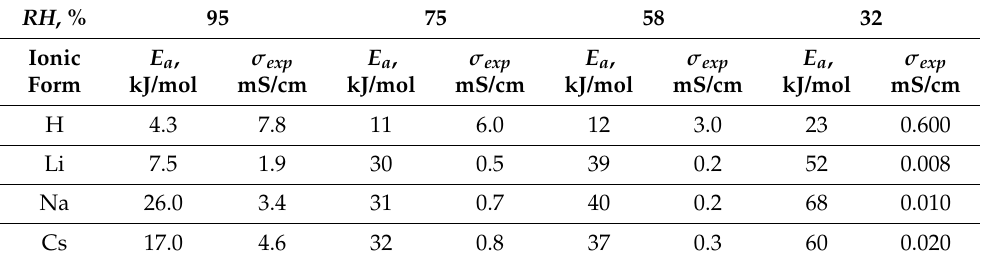
Table 10. Experimental values of ionic conductivity at 25 ◦ C and conductivity activation energies of H + , Li + , Na + , Cs + cations in MSC membrane with different humidity. Ion exchange capacity is 2.5 mg-eq/g [17].